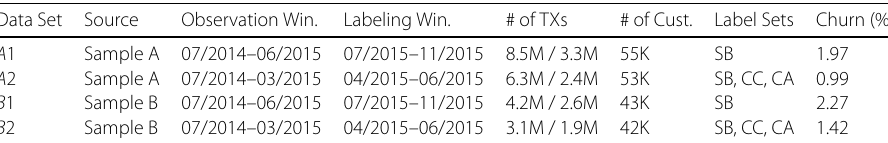
Table 1 Data set